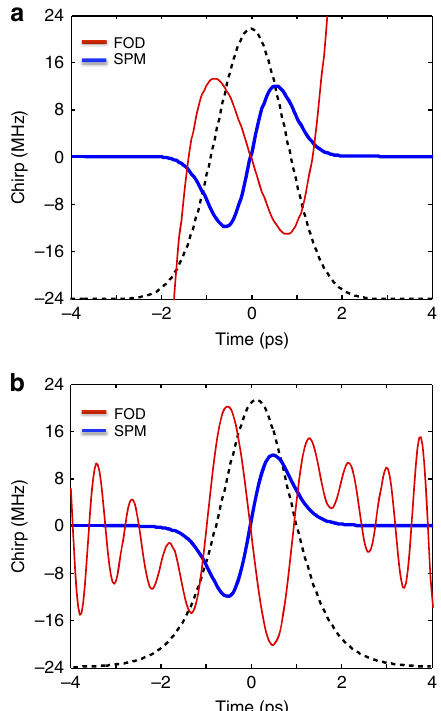
Figure 5 | The cancellation of nonlinear and dispersive phase components on the fundamental pure-quartic soliton. ( a ) FOD-induced (red) and SPM-induced (blue) frequency chirps after a propagation of L FOD /10 for the Gaussian pure-quartic soliton of equation (3); ( b ) similar, but for the sech 2 type solutions obtained taking ref. 18 with b 2 ¼ 0. The dashed black curves in the background of ( a ) and ( b ) represent the input pulse intensity: the Gaussian solution of equation 3 and the sech 2 solution in ref. 18